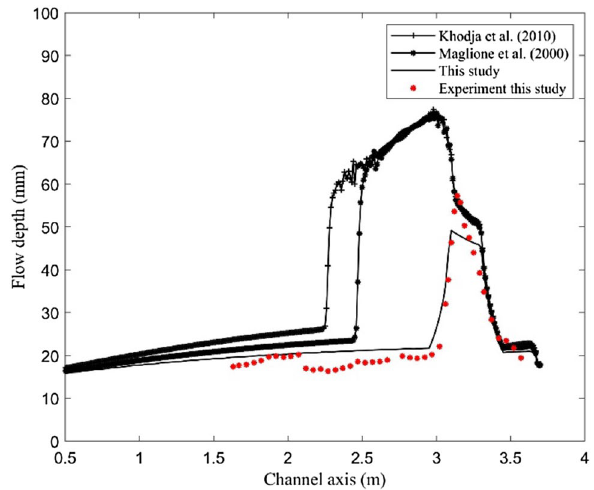
Fig. 7 Flow depth variation with steps change of inlet flow rate: the ultrasonic level sensor is positioned LT-18 and LT-15 at x = 2.12 and m. The channel is at the horizontal angle. The left ver- tical axis demonstrates the flow depth in mm, and the right vertical axis demonstrates the flow rate in kg min −1